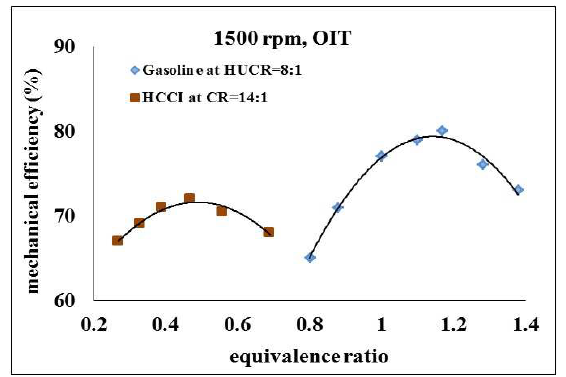
HCCI engine produced high brake power with lower brake specific fuel consumption compared with the SI engine. As Fig. 10 shows, the brake thermal efficiency of HCCI exceeded gasoline engine.